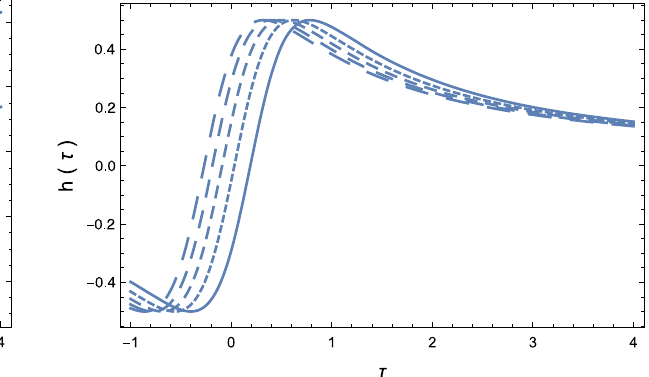
Fig. 9 Time evolution of the scale factor a (left figure) and of the dimensionless Hubble function h (right figure) in a loop quantum cos- mological Universe filled with a deformed photon gas satisfying the dispersion relation E = kc ( 1 − α k ) , for different values of the parame- ter A 4 : A 4 = 4 × 10 − 58 (solid curve), A 4 = 5 × 10 − 58 (dotted curve),